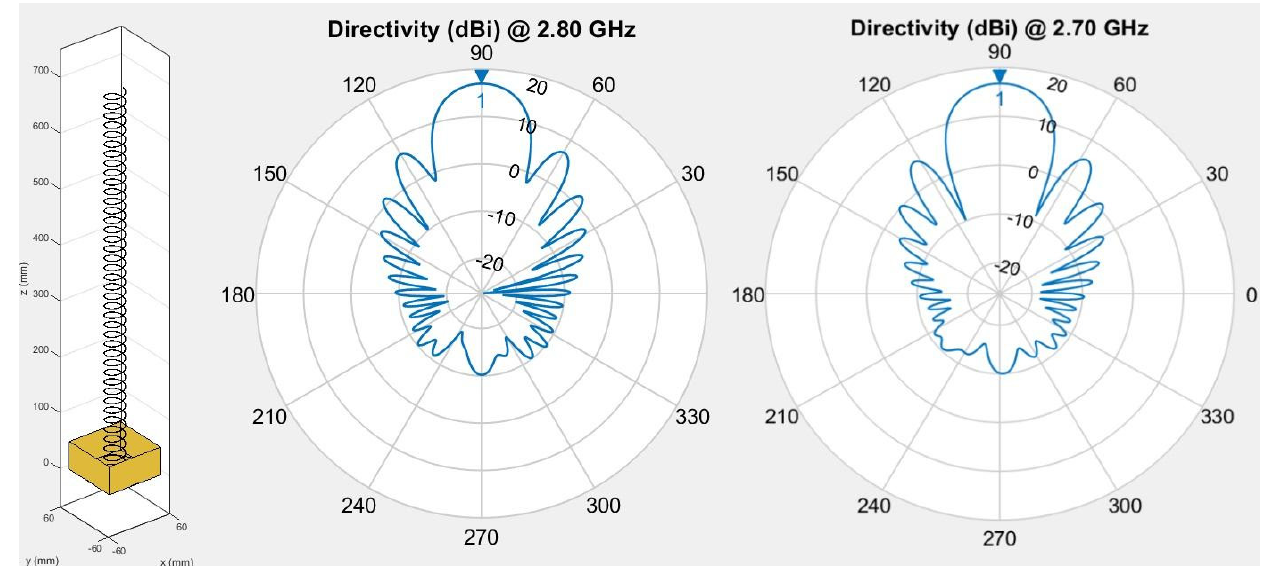
Figure 10. Approximate directivity for a 40-turn helical antenna at 2695 MHz and 2800 MHz using the MATLAB Antenna Designer. The antenna is shown within a box representing the deployment module. At 2800 MHz, a half-power beamwidth (HPBW) of 23° and directivity of 17 dBi is achieved. At 2695 MHz, the same geometry produces an HPBW of 25° and directivity of 16.7 dBi. Table 6. Data collection channels for